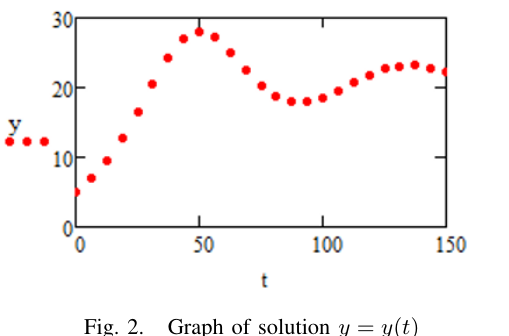
Fig. 2. Graph of solution y = y ( t